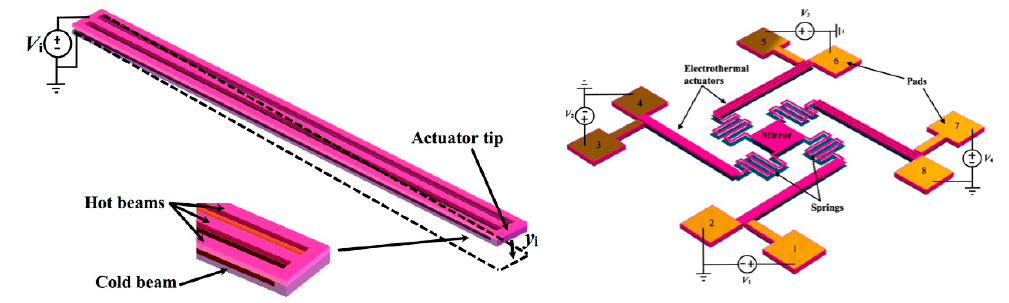
Figure 4. Out-of-plane hot-and-cold-arm actuators: Micromirror [65].